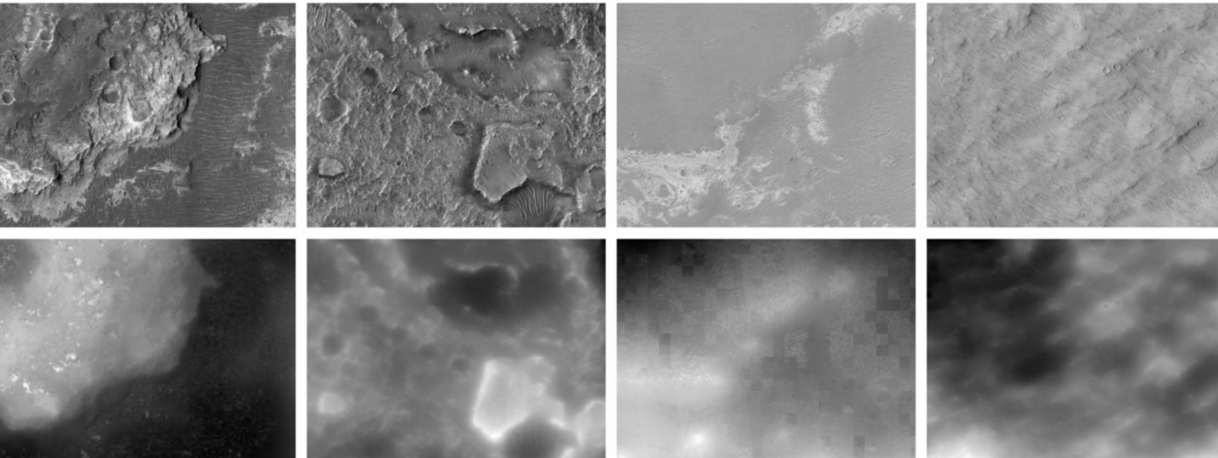
Figure 8. Examples of the training samples (before screening) showing the lower quality DTMs (1st and 3rd columns) and the higher quality DTMs (2nd and 4th columns). The mean SSIM values for the images and their corresponding shaded relief images of the DTMs (using the same lighting elevation azimuth angles) are 0.2609, 0.461294, 0.2985, 0.5398 from left to right. It should be noted that both the 1st and 2nd columns, and 3rd and 4th columns show similar surface features with similar image quality but with completely different DTM quality. N.B. the DTM crops were rescaled for a range from 0 (black) to 1